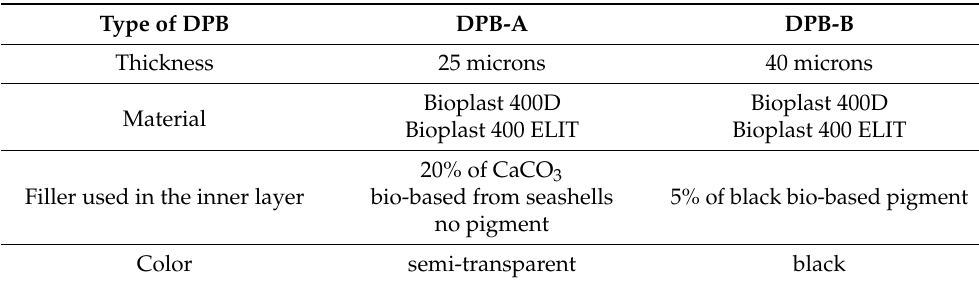
Table 1. Biodegradable non-fossil derived plastic films A and B, which were used to manufacture dog poop bags (DPB-A and DPB-B).